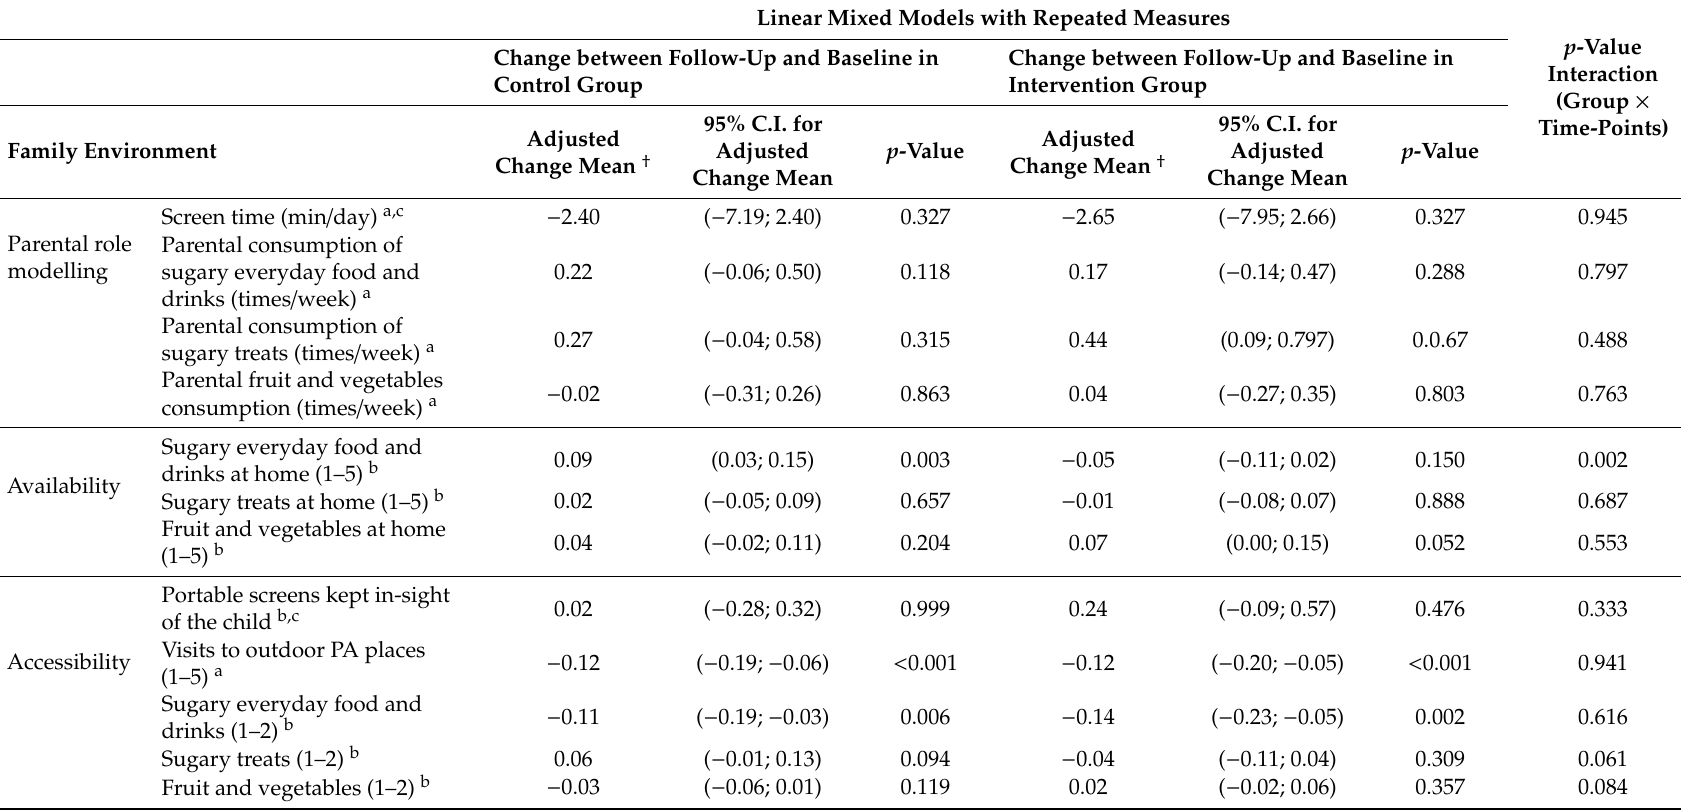
Table 4. Comparison of parental role modeling, availability and accessibility between baseline and follow-up in control and intervention groups ( n = 625–722).